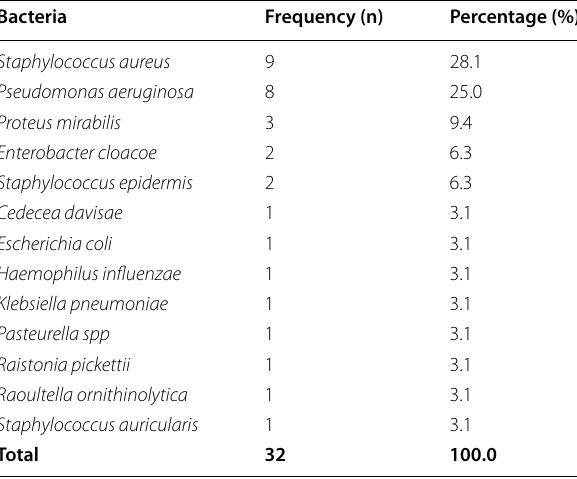
Table 5 Frequency of bacteria isolated from ear secretions Bacteria